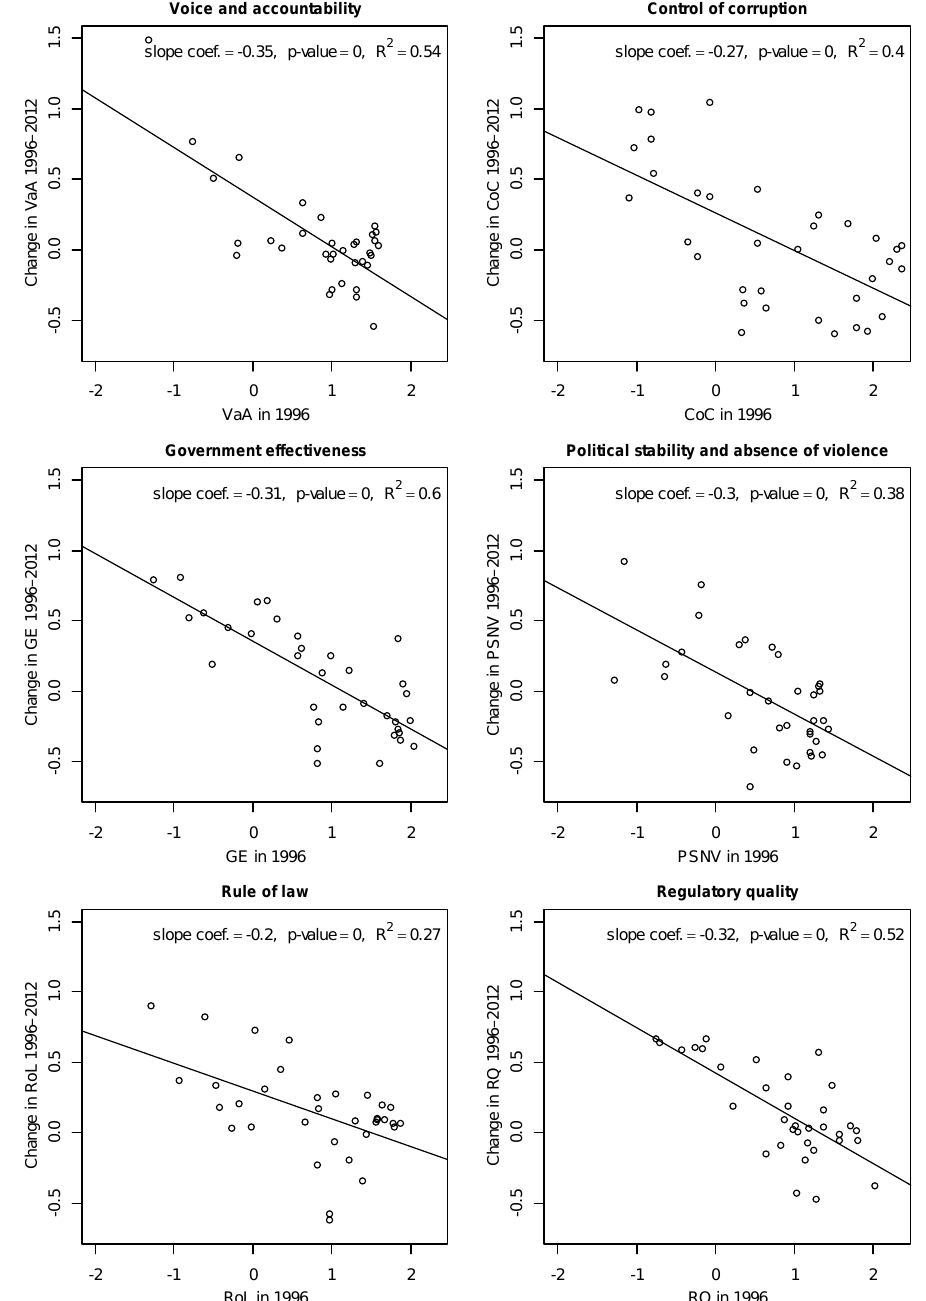
Figure 3 : WGIs’ β -convergence in the European Union including its